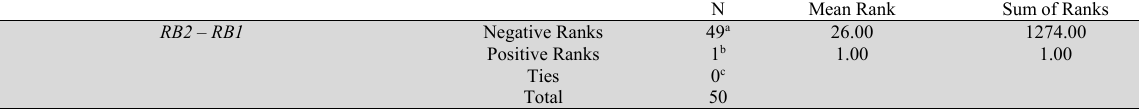
The result of the paired comparison of data on the Wilcoxon Test